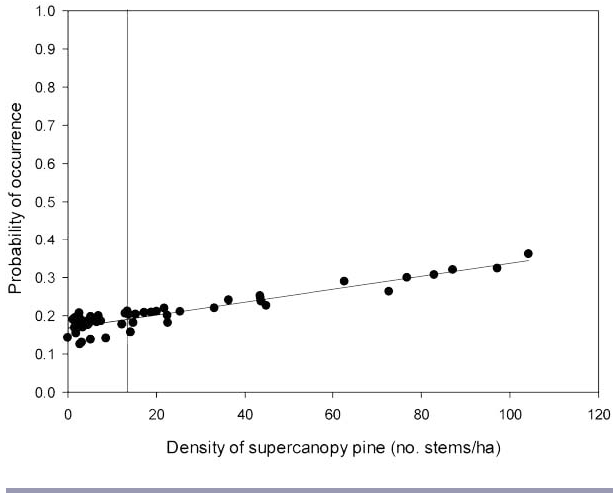
Fig. 7 . Relationship between the density of supercanopy pine trees and the probability of occurrence of Pileated Woodpecker in pine forests. Threshold derived from ROC curve is shown as vertical line (see Methods).